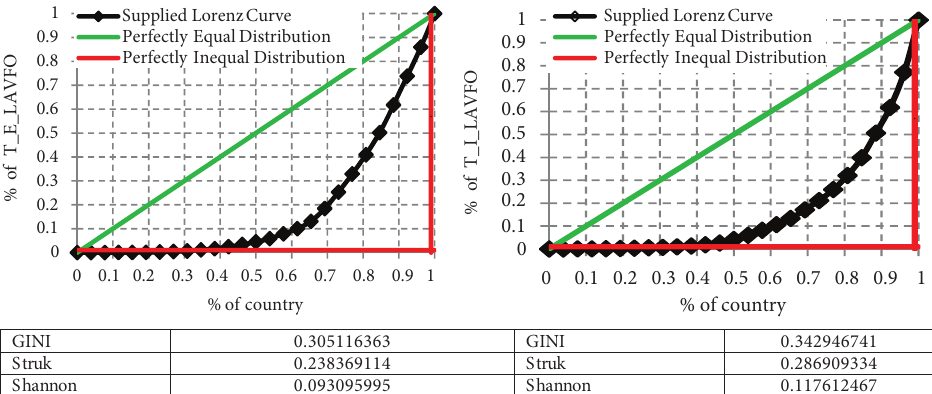
Figure 3. Concentration graph of Total exports and Total imports of live animals and animal products, vegetable products, vegetable or animal fats and oils of Romania in EU, cumulated values, 2007–2016 (source: authors’ own